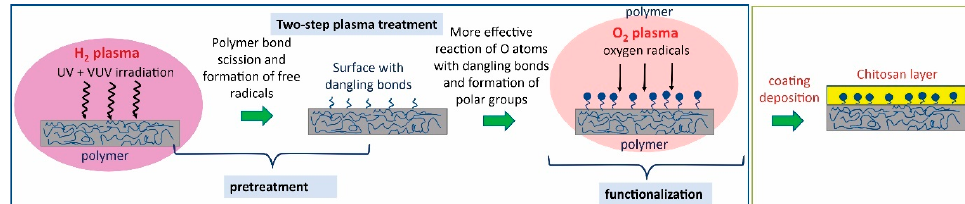
Figure 2. Scheme of preparation of coated catheters based on two-step plasma pretreatment followed by deposition of chitosan layers.